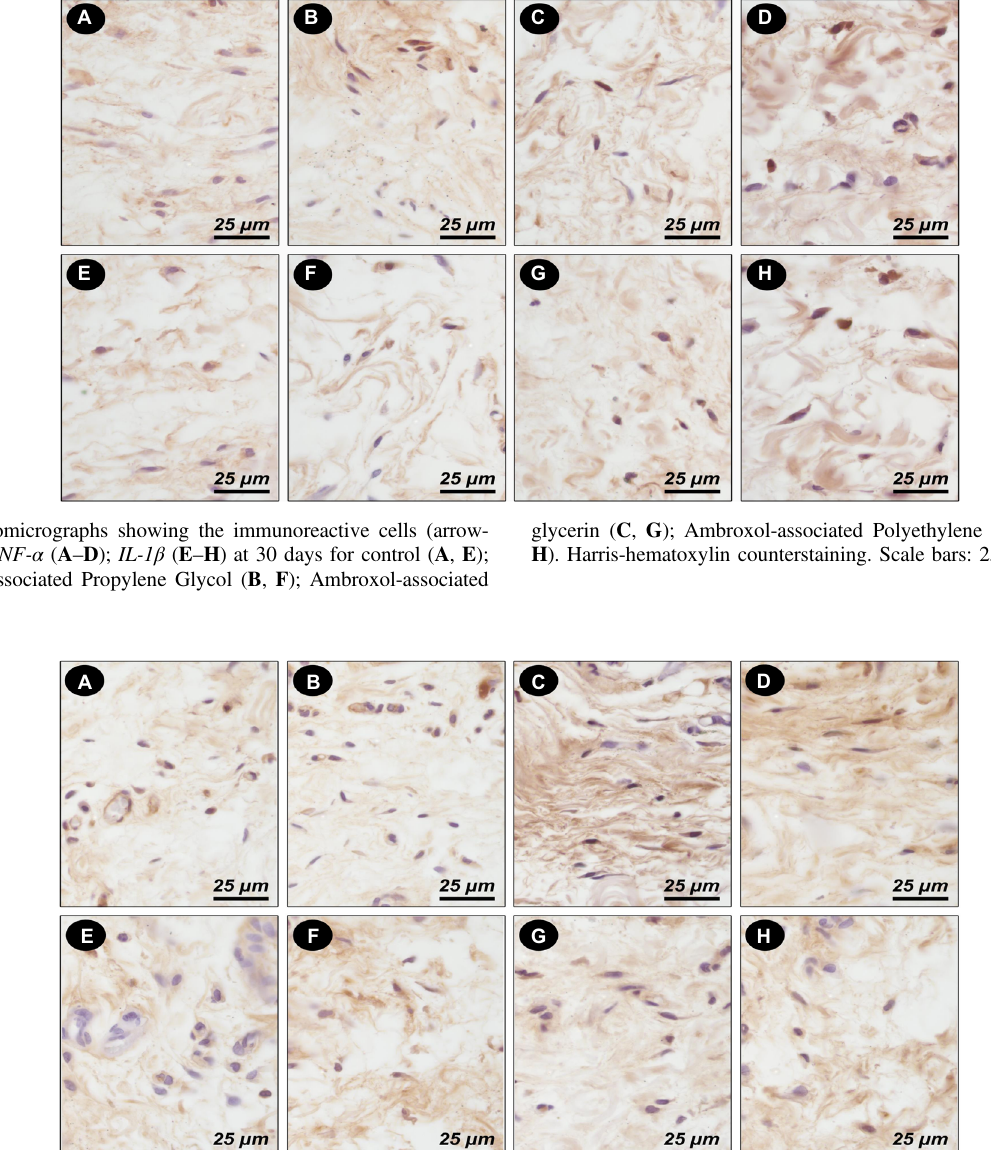
glycerin ( C , G ); Ambroxol-associated Polyethylene Glycol 400 ( D , H ). Harris-hematoxylin counterstaining. Scale bars: 25 μ m